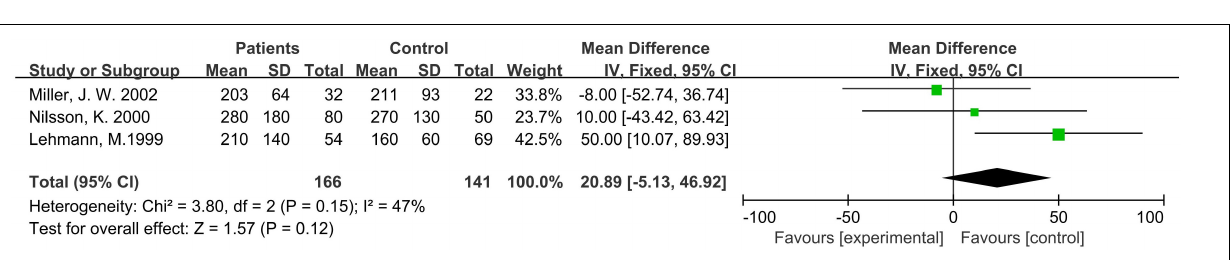
FIGURE 5 | Forest plot of the association between MMA and dementia in the three case-control studies.